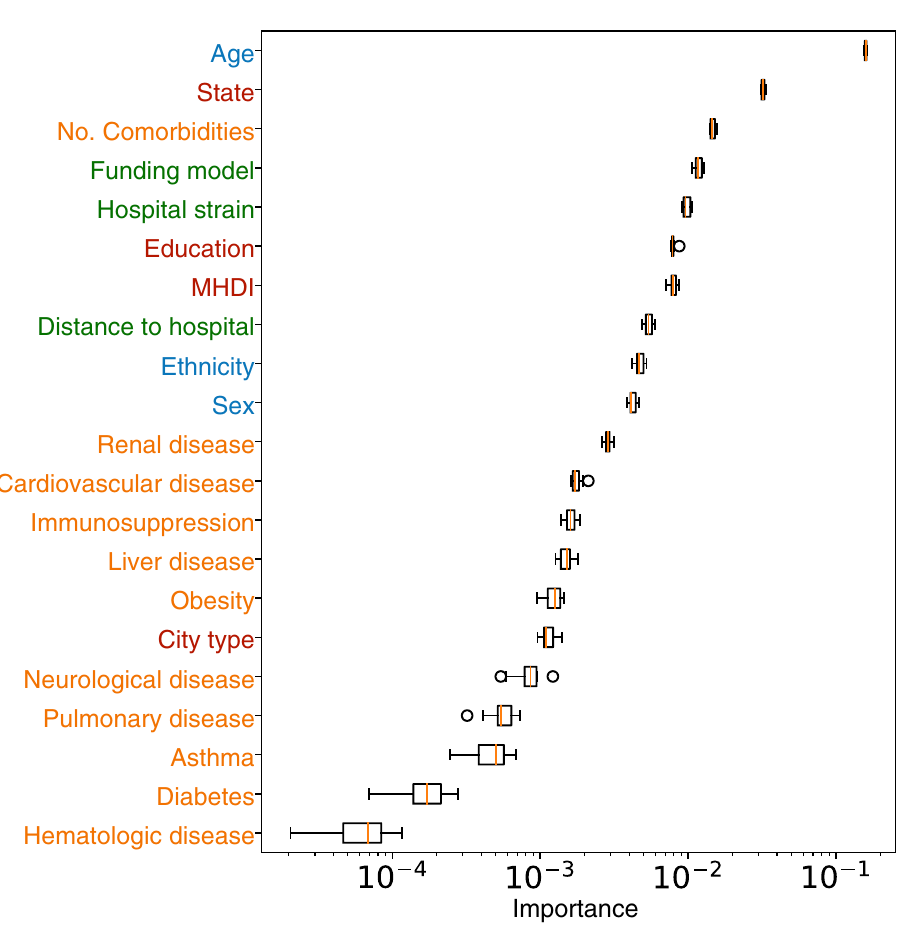
Figure 4. Relative feature importance (median and IQR) for mortality risk to COVID-19. The coloring marks the categories listed in Fig. 1. Feature importance is estimated via the permutation method and a logarithmic scale is employed for